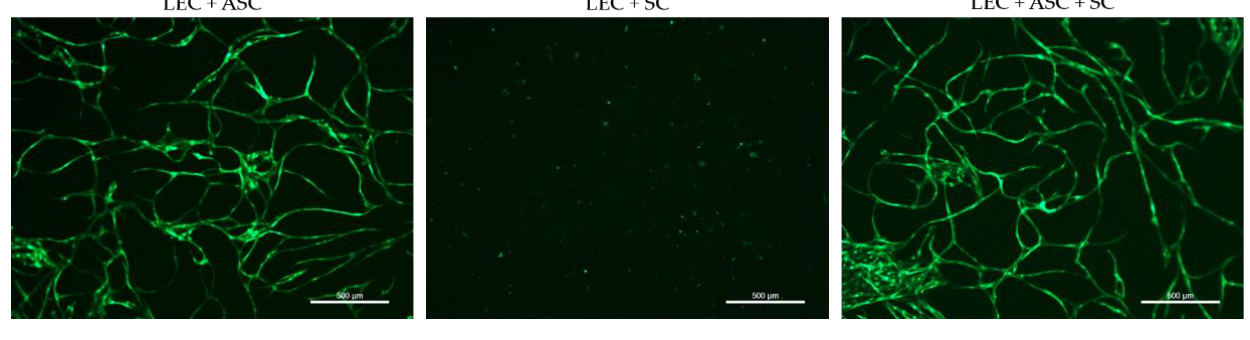
Figure 3. 2D culture of YFP-LECs (green) with either ASCs or SCs alone, or with both ASCs and SCs. Cells were seeded in equal densities. Elongated lymphatic network-like structures formed when LECs were co-cultured with ASCs as well as with both ASCs and SCs. In contrast, LECs remained as single cells but also seemed to decrease in number when cultured with SCs alone. Green — YFP-LECs. Scale bars = 500 µm.